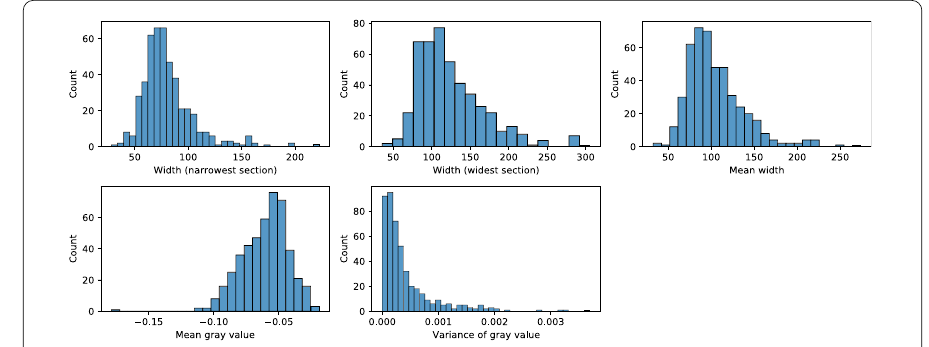
Figure 10 Histograms of various fibril properties. Note that all histograms exhibit a large variance but do not show clear multi-modal